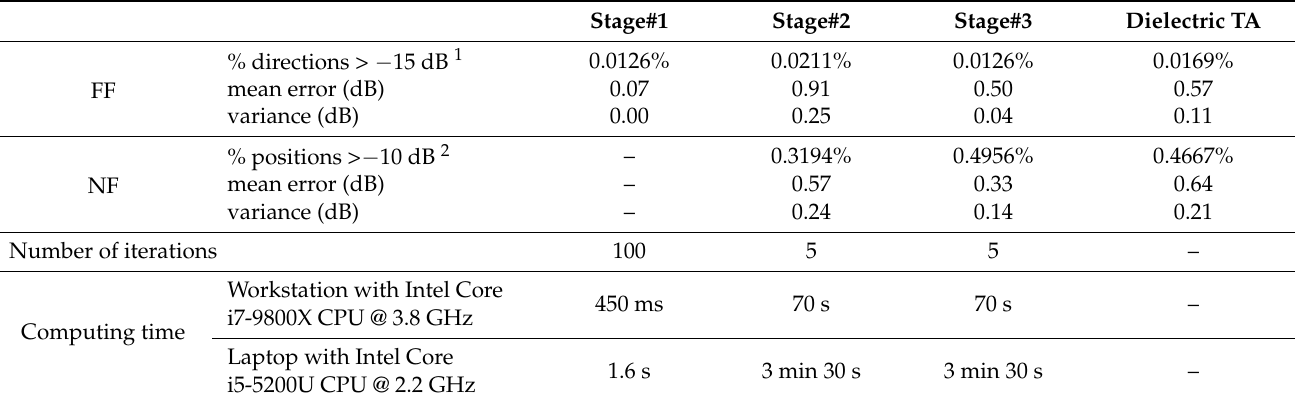
Table 1. Case 1. Summary of synthesis results: errors and computing